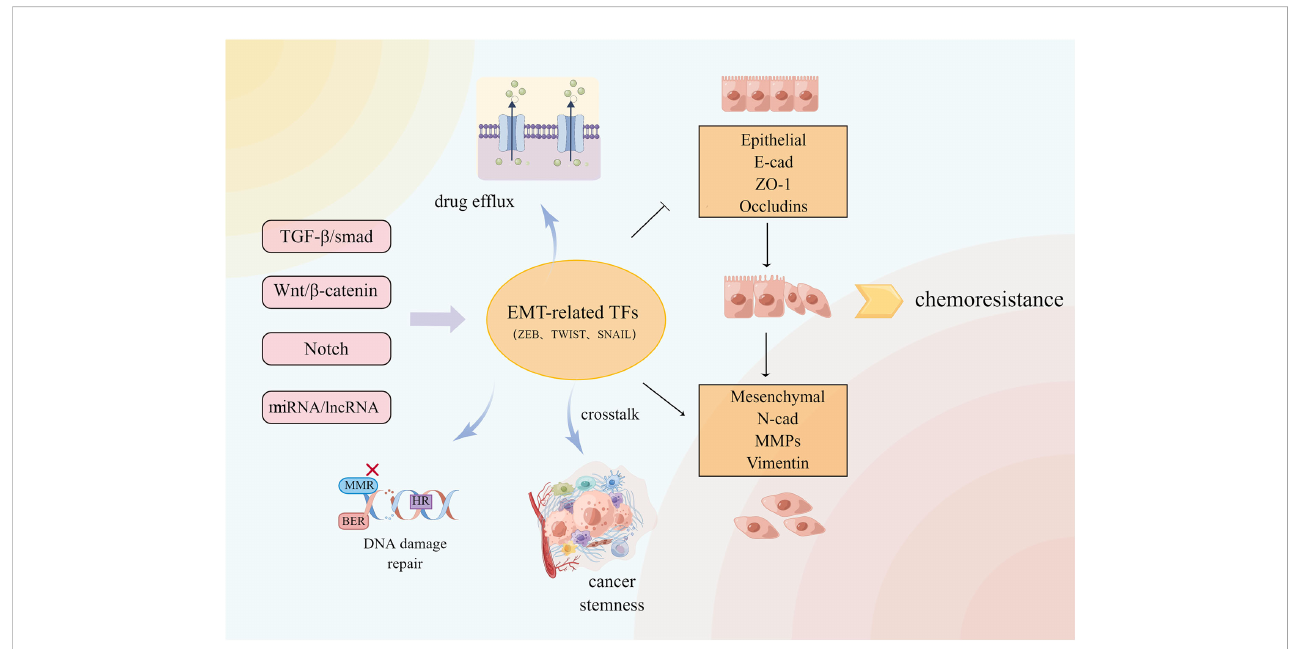
FIGURE 5 A variety of signal pathways regulate EMT-related transcription factors and downstream related pathways. EMT and crosstalk with TME, DNA damage repair and so on cause CRC